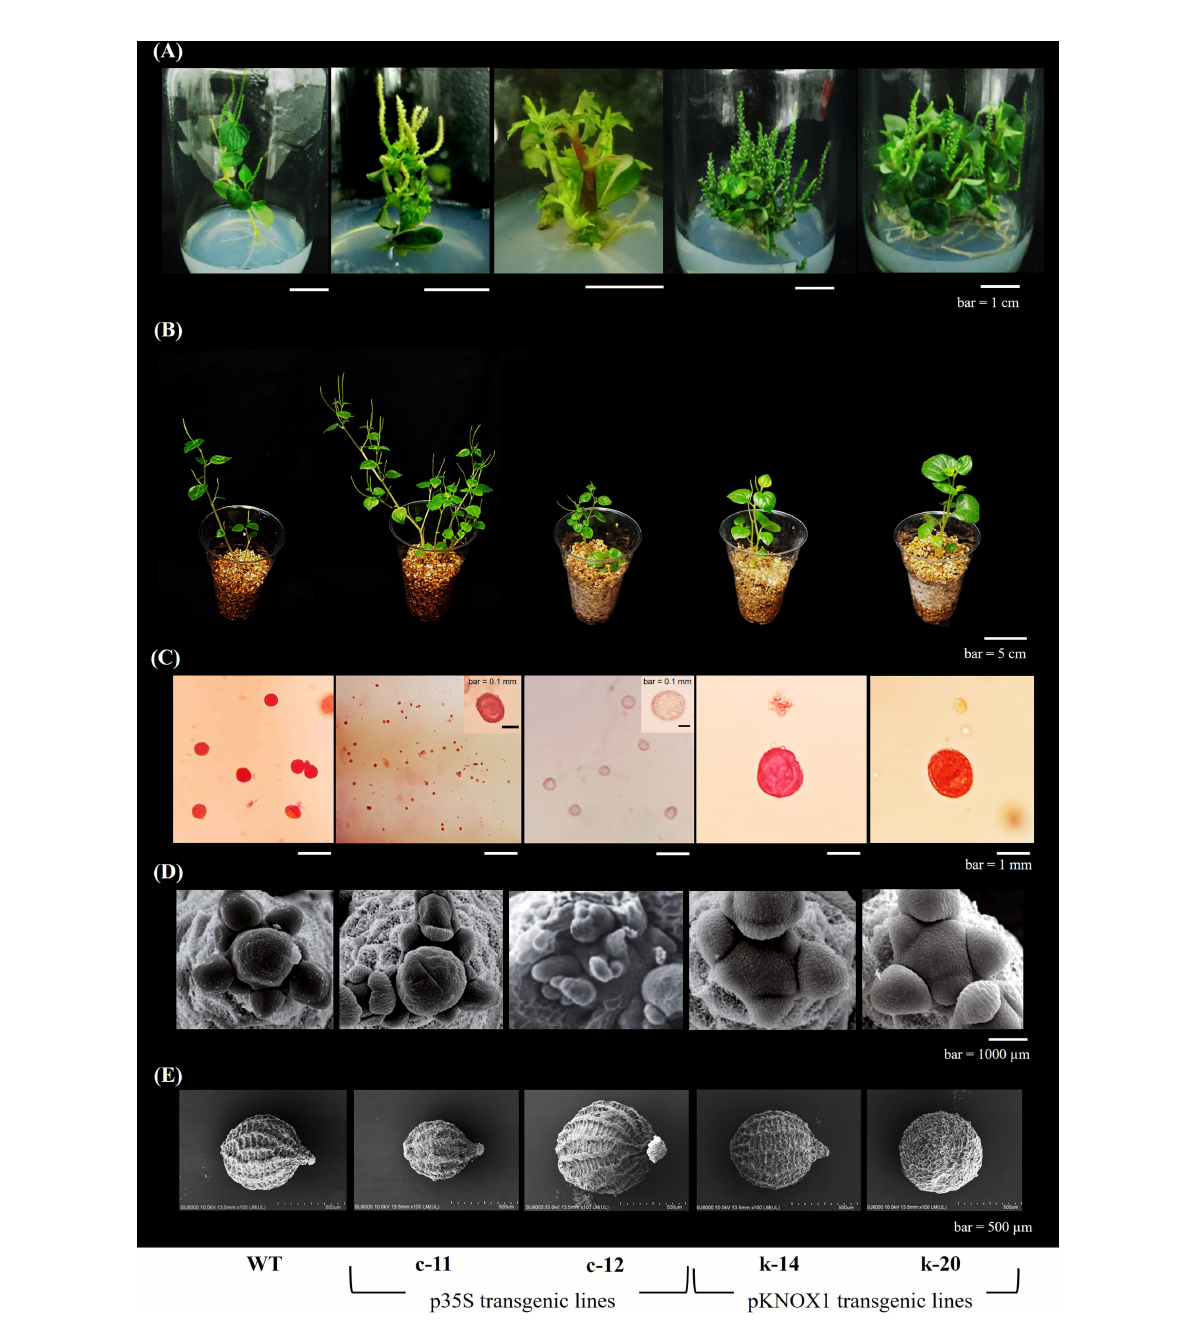
FIGURE 2 Phenotypic characters of P. pellucida reveal for in vitro plantlets (A) , morphological growth of transplants at 30 days of transplantation (B) , pollen size and viability stained with safranin (C) , scanning electron microscope (SEM) of shoot apical meristem (D) and SEM of seed (E) . The T 1 - transgenic lines obtained from different promoters as p35S transformant (c-11) and pKNOX1 transformants (k-14 and k-20) were compared with wildtype